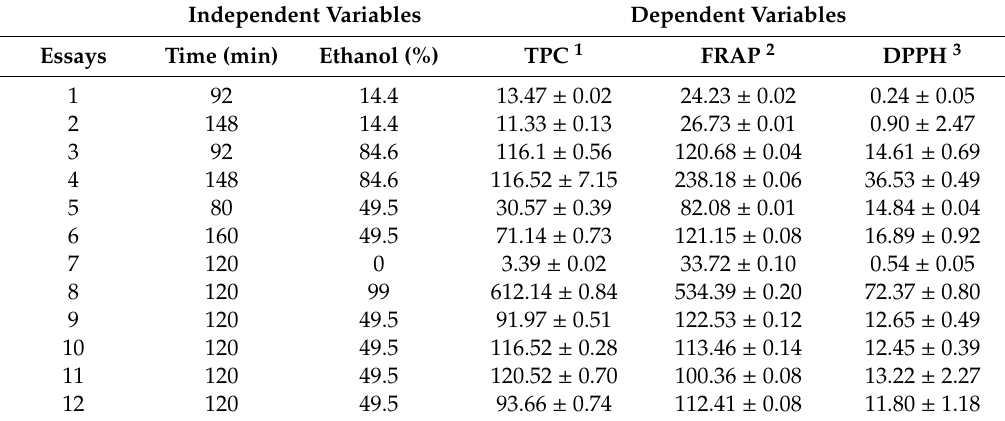
Table 2. Real values of the independent and dependent variables observed.